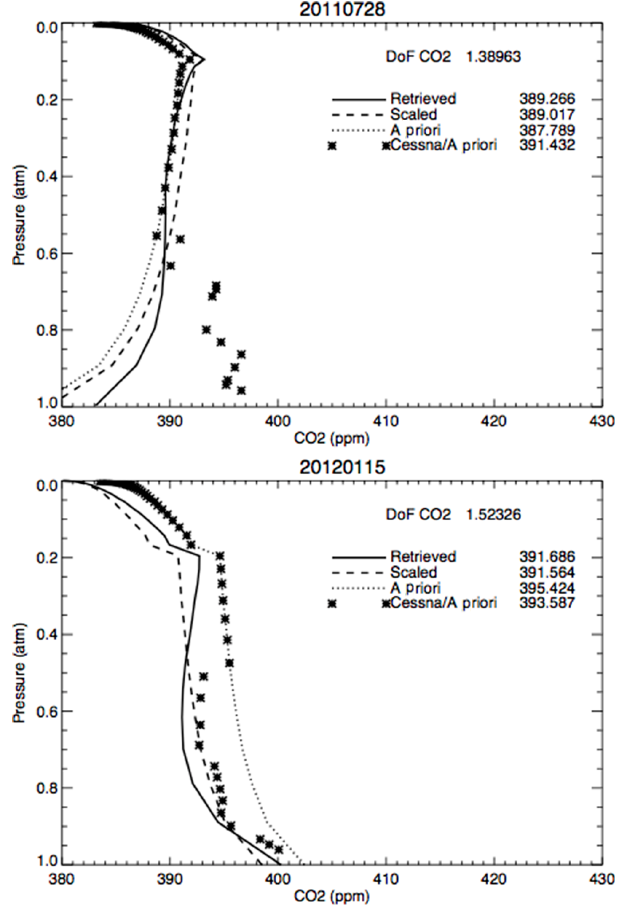
Figure 9. (a) Average retrieval within about 1h of a Cessna over- flight, assuming SNR = 100, on 28 July 2011. (b) As (a) but for 15 January 2012.